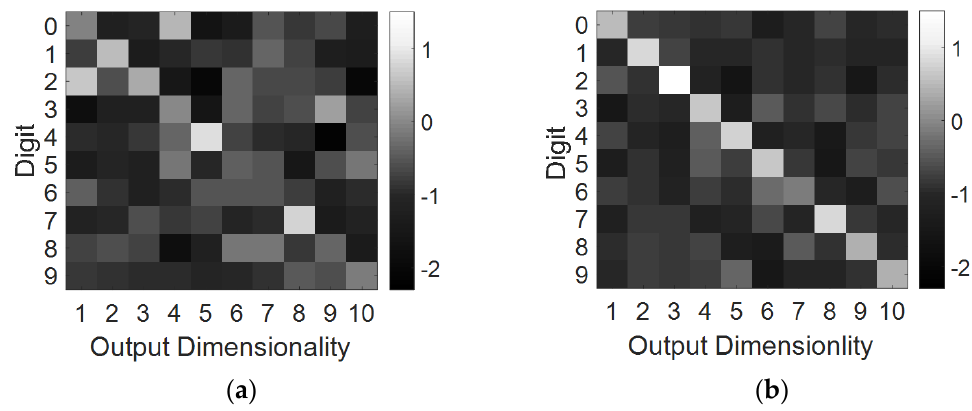
Figure 7. Handwritten digit recognition of 0–9 using ( a ) conventional RC and ( b ) proposed RC. The interval of 𝜃 = 4 ps corresponds to a processing speed of about 𝑇 (cid:2879)(cid:2869) = 625 MSample/s .